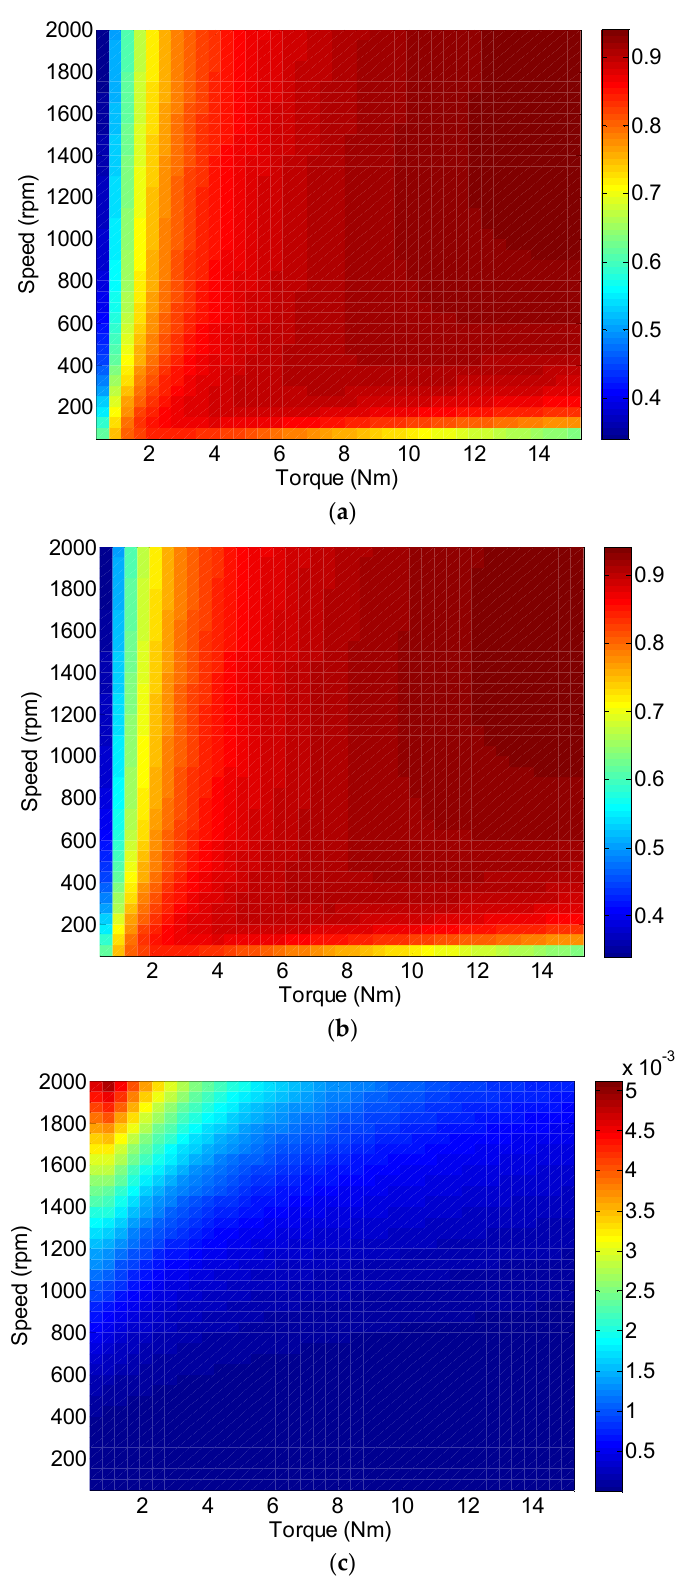
Figure 12. Results of the PMSM in SVPWM: ( a ) Efficiency of PMSM in traditional i d = 0 control; ( b ) Efficiency of PMSM in proposed MEPT control; ( c ) Difference of efficiency between i d = 0 control and MEPT control.